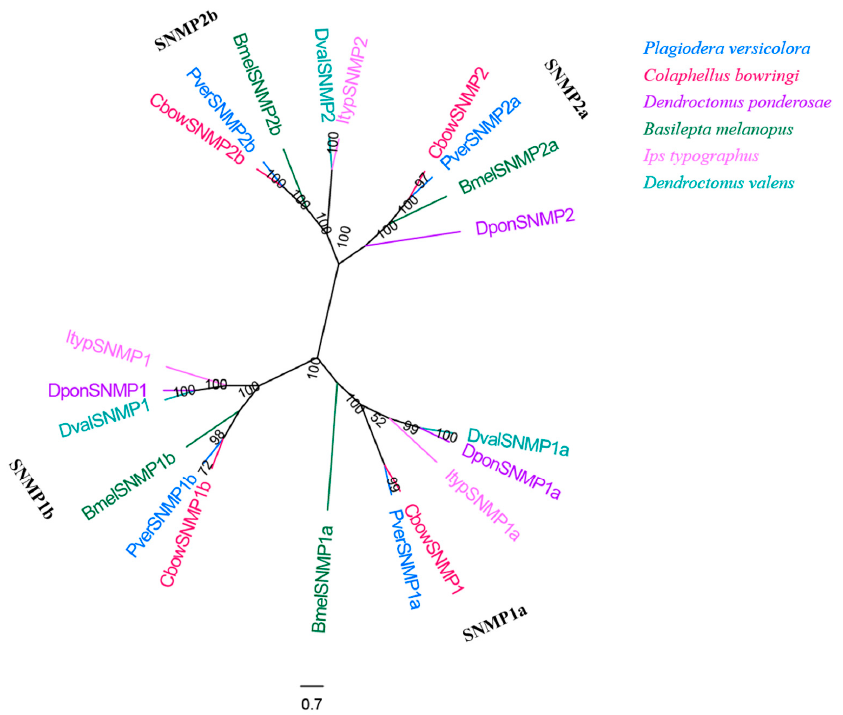
Figure 10. Phylogenetic tree of insect SNMP. The P. versicolora genes are shown in blue. The tree was constructed using MEGA6 with the Neighbor-joining method. constructed using MEGA6 with the Neighbor-joining